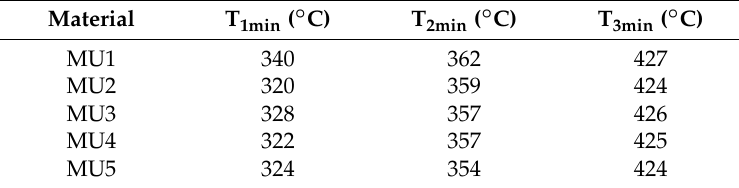
Table 4. Temperature values of successive degradation stages.